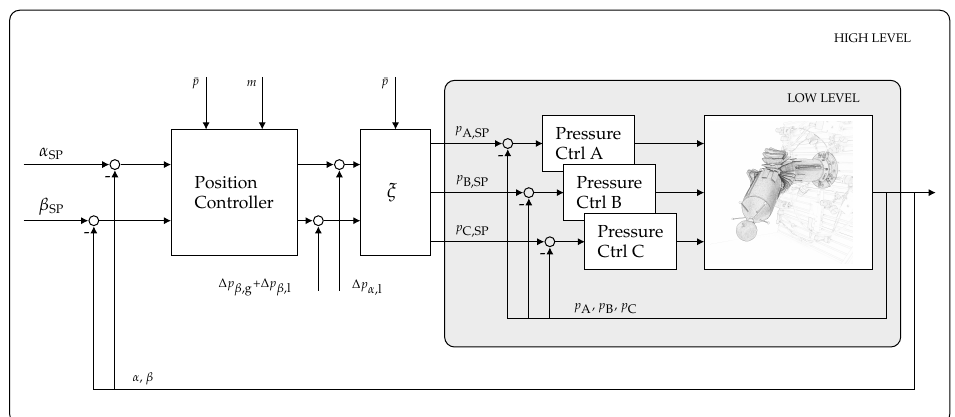
Figure 14. The cascaded control architecture employed for the soft robotic arm. The architecture is structured into a low level part that is executed at 1000Hz on an embedded hardware and a high level part that is executed on a laptop computer at 50Hz. A timescale separation between the pressure and arm dynamics is exploited, where each actuator pressure is controlled by a proportional-integral- derivative controller in a separate inner control loop. The position controller in the outer loop uses sensory feedback of the angles to compute two virtual control inputs ∆ p α ,SP and ∆ p β ,SP . The gain scheduled position controller depends on the commanded value for ¯ p and the known payload mass m . The control allocation strategy is applied to map the virtual control inputs to the actuator pressure set points that are the reference signals for the inner loops. Feed forward control action is added to compensate for the effect of gravity and a longitudinal actuation of the